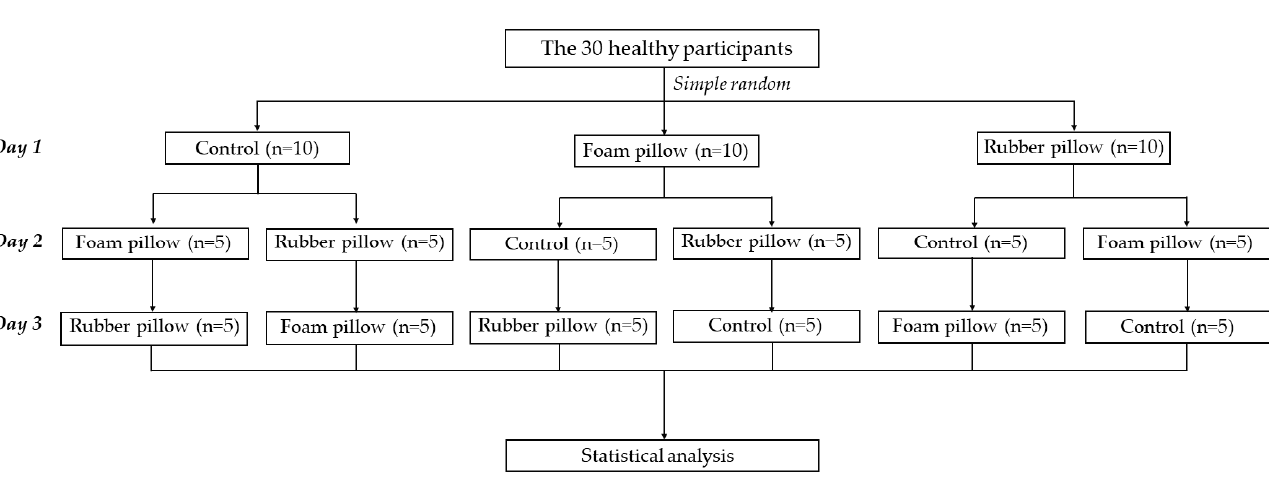
Figure 1. Overview of the study.